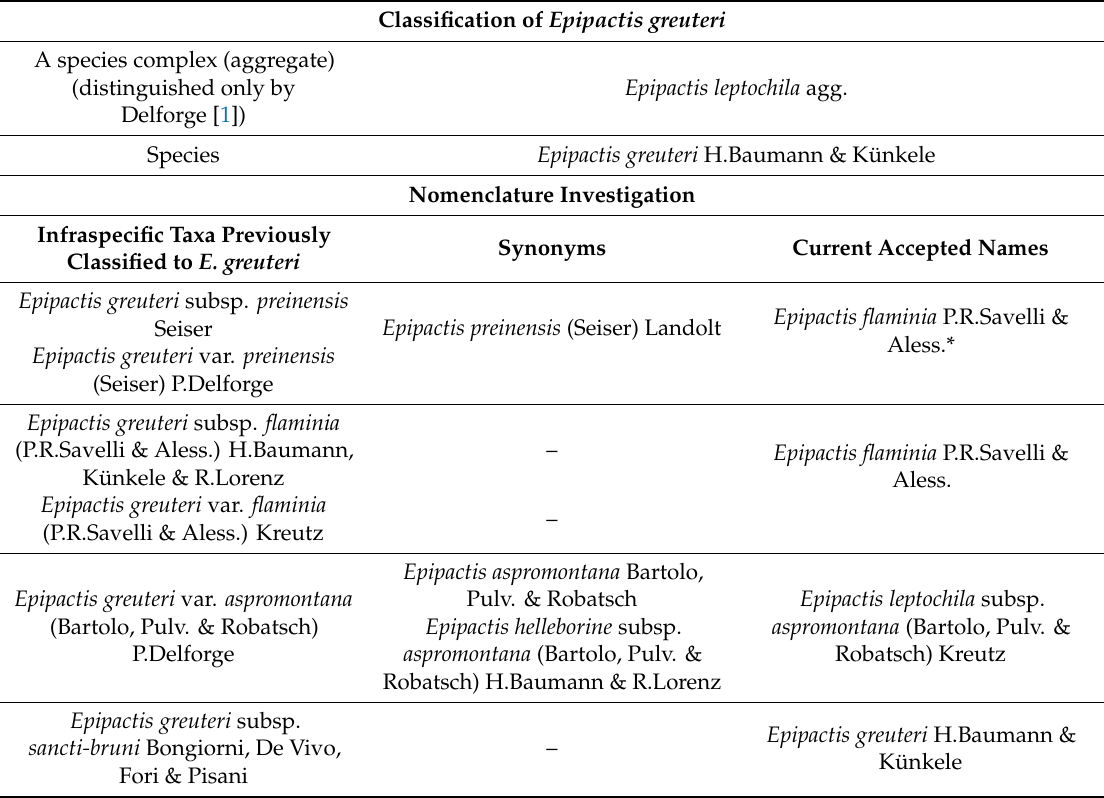
Table 3. Taxonomic treatment of Epipactis greuteri , according to Delforge [1] and online databases [38,39]. Classification of Epipactis